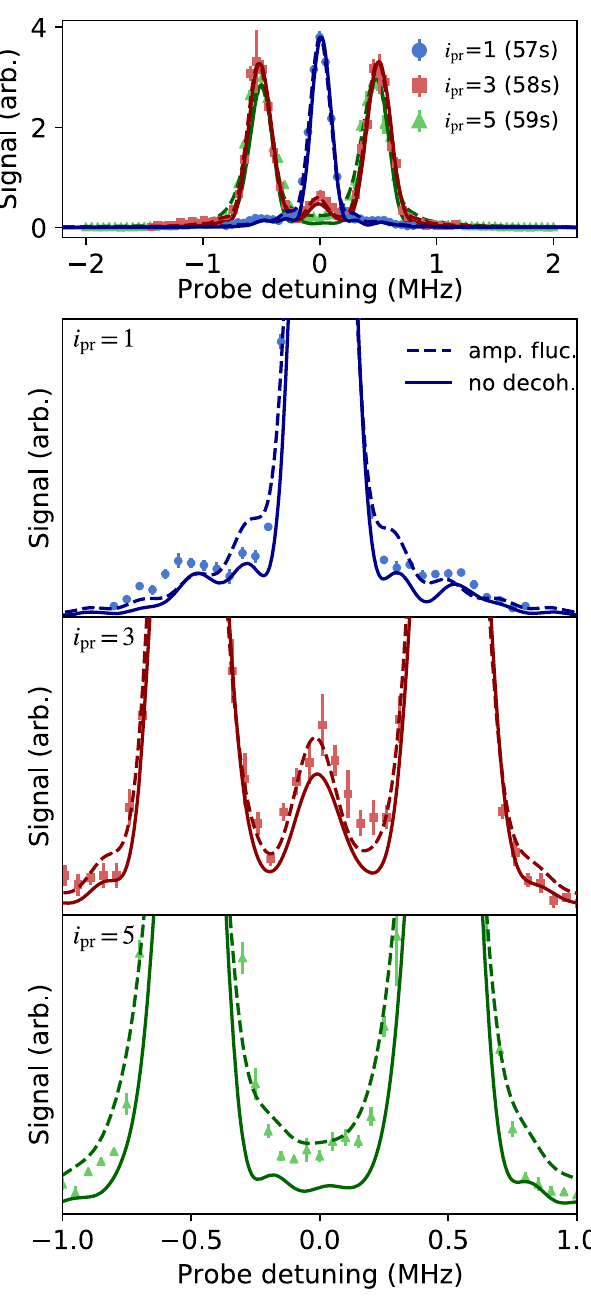
Fig. 8 Noise model analysis. Same as Fig. 7, but experimental data shown are for J s / J w = 5 [from Fig. 2a]. Top panel shows all three i pr while the bottom three panels show central regions of the same data for the individual i pr indicated in each panel. All error bars denote one s.e. of the